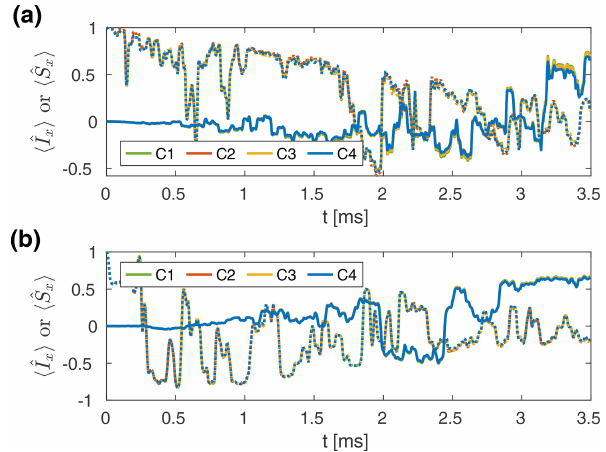
Figure 7. Simulated time evolution of the ˆ I x (dotted lines; 15 N) and ˆ S x (solid lines; 13 C) operators during tm-SPICE (Tošner et al., 2018) CP polarization transfers in NCA (a) and NCO (b) two-spin systems (see Tables S2 and S3 for spin system parameters) in a 3.2mm MAS probe at a proton resonance frequency of 400MHz. A spinning frequency of 20kHz was assumed, and the nominal rf amplitudes were set to 40kHz on both channels. Impressive transfer efficiencies of approximately 60% are achieved in both spin pairs. However, no significant differences between the four cases C1–C4 are